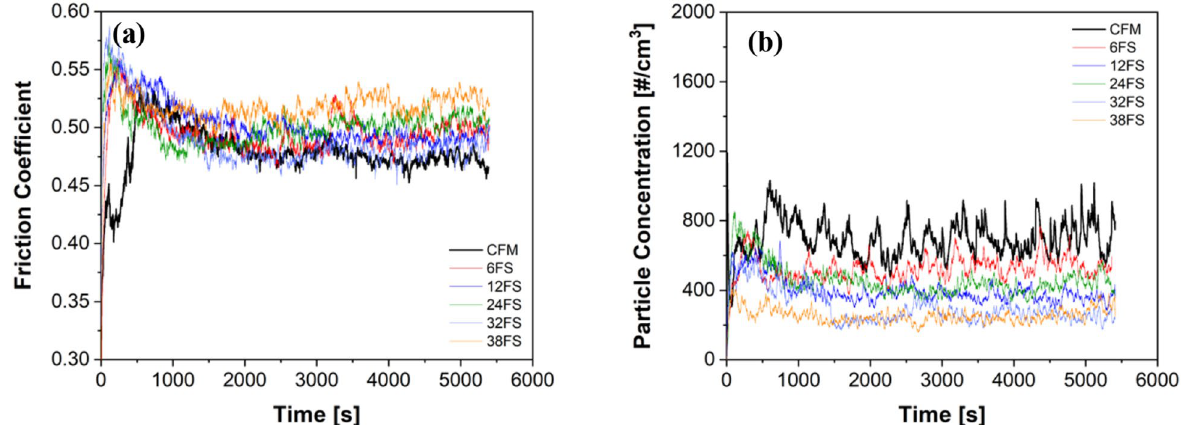
Figure 3. ( a ) Friction traces; ( b ) Emission trends of CFM and with the FS slag